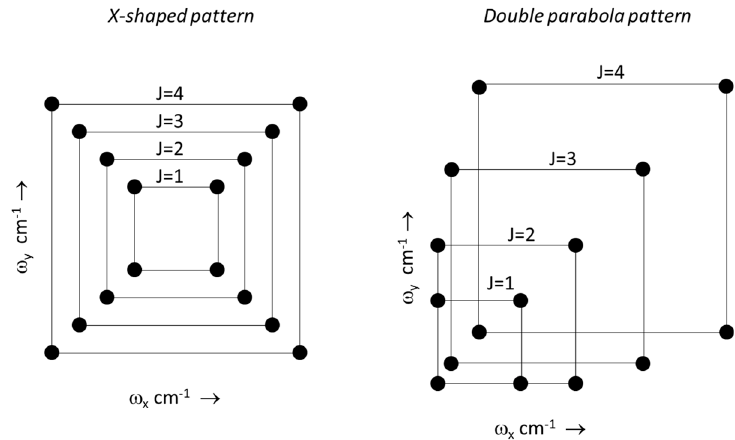
Figure 1. Rotational patterns observed in HRC2DS appear with the shape of an X (if the rotational constants for upper and lower levels are similar) or a double parabola (if the rotational constants for the upper and lower levels are different). Each dot represents a peak (coming out of the page) in 2D space. In both cases, the basic pattern consists of four peaks that form a rectangle.